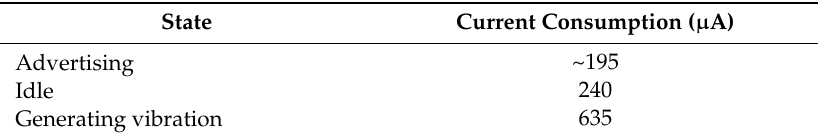
Table 1. Measured current consumption of the gadget at different states.